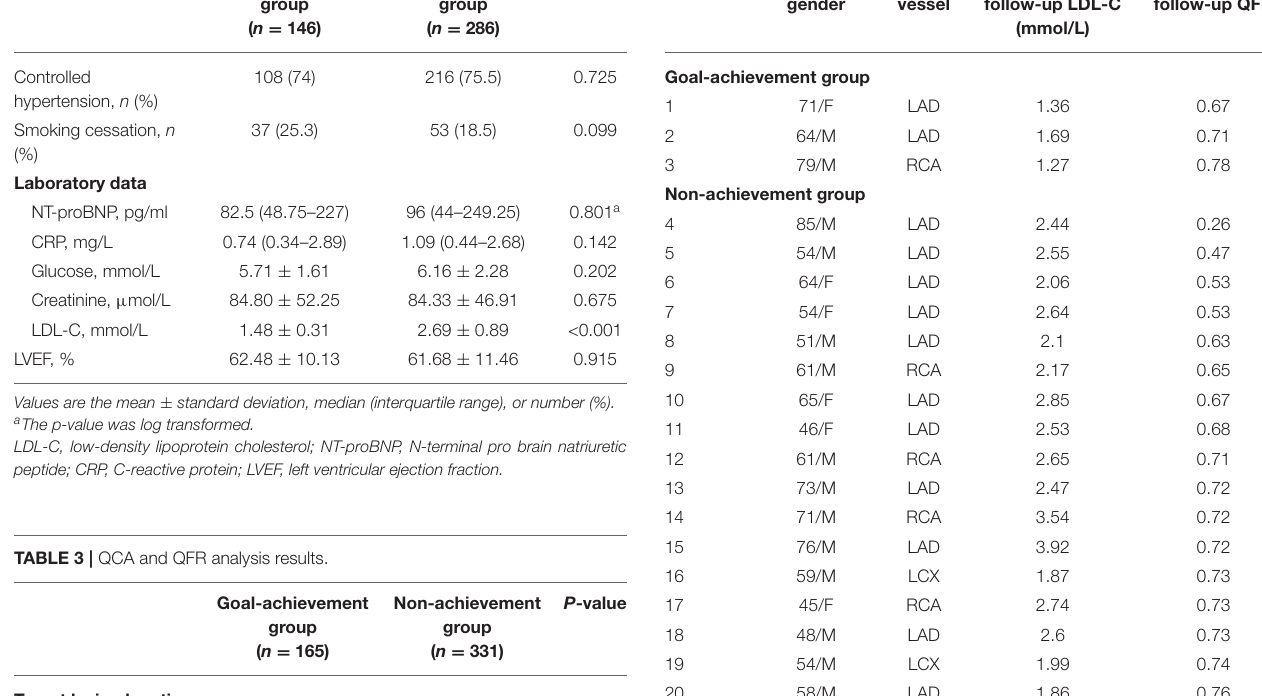
TABLE 4 | Incidence of physiological restenosis. Case